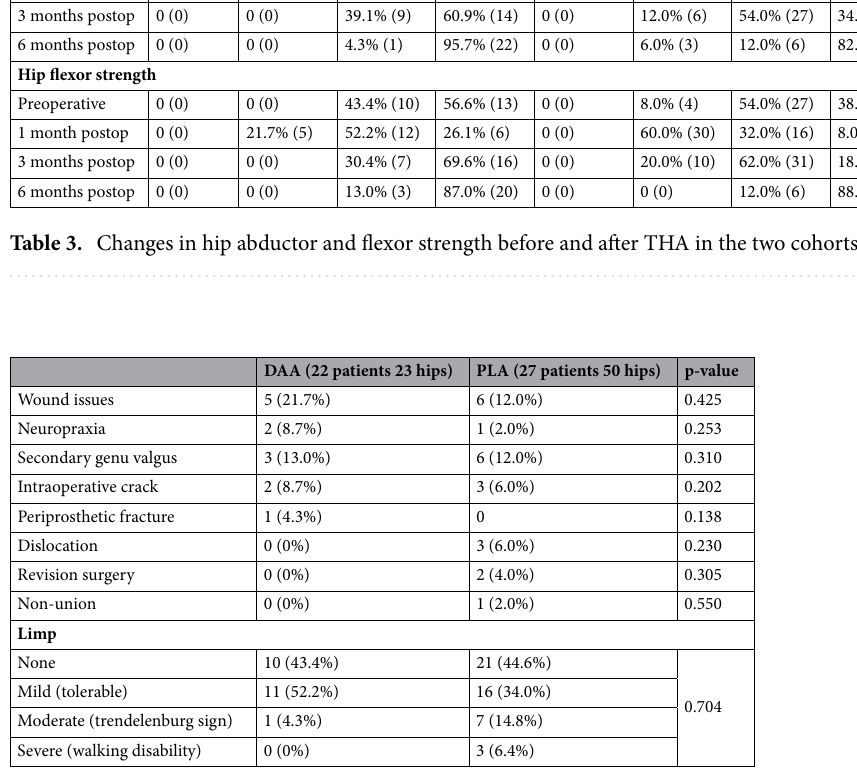
Table 4. Post-operative complications and limp recovery in the two cohorts at the final